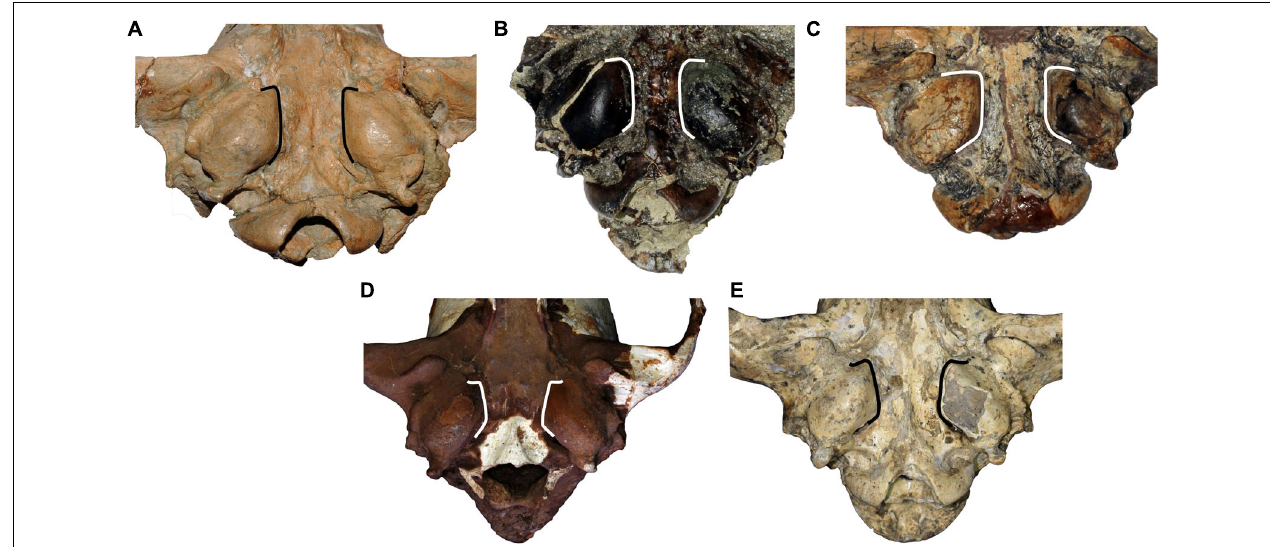
FIGURE 2 | Comparison of the tympanic region of (A) C. etruscus from Upper Valdarno, (B) C. arnensis from Poggio Rosso, (C) C. chihliensis from Yushe Basin, (D) C. mosbachensis from Cueva Victoria, and (E) Canis from Dmanisi. Note the marked divergence of the medial walls of the tympanic bullae of C. mosbachensis and of Canis from Dmanisi. This feature is not documented in the fossil taxa but present in extant wolf-related species (like C. lupus , C. lupaster , C. aureus , etc.).